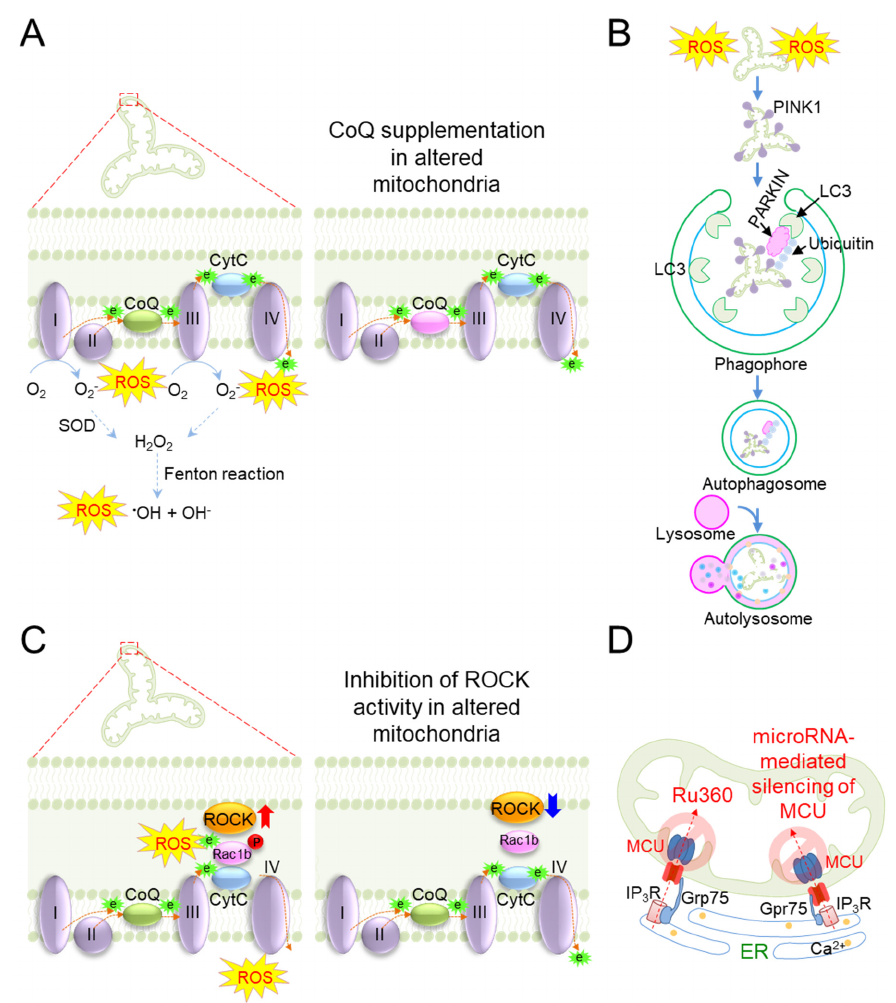
Figure 5. Targeting mitochondrial oxidative stress as a therapeutic strategy for aging and age-related diseases: ( A ) Senescent cells show a lack of coenzyme Q (CoQ), which transports electrons from complex II to III (green CoQ indicates CoQ deficiency). Senescent cells deficient in CoQ exhibit electron leakage as electron transport in ETC is hindered. Premature electron leakage from ETC combines with oxygen to generate mitochondrial ROS. By contrast, mitochondria-targeted CoQ (MitoQ) treatment lowers mitochondrial ROS production, consequently resulting in a significant reduction in senescence-associated symptoms (pink CoQ indicates high levels of CoQ); e: electron. ( B ) Mitochondria damaged by high levels of mitochondrial ROS recruit PTEN-induced putative kinase protein 1 (PINK1) and ubiquitin ligase PARKIN. PINK1 activates PARKIN recruitment to the OMM for ubiquitylation of OMM proteins in damaged mitochondria. The creation of polyubiquitin chains in OMM proteins recruits autophagy receptor proteins that interact with LC3 (microtubule-associated protein 1A/1B light chain 3) in the phagophore. Then, damaged mitochondria are eliminated by the subsequent formation of the phagophores, autophagosomes, and autolysosomes. ( C ) Reduction in mitochondrial oxidative damage by directly targeting genes that regulate the activity of ETC components. ROCK activation phosphorylates Rac1b, making it easier for Rac1b to interact with cytochrome c. This interaction steals electrons from cytochrome c and causes a partial reduction in oxygen, triggering mitochondrial ROS production. Inhibition of ROCK activity prevents Rac1b from intercepting electrons from cytochrome c, enabling electron transport from complex III to IV. Then, efficient electron transport facilitates complex IV activity, thereby reducing mitochondrial ROS production; e: electron. ( D ) Inhibition of MCU by ruthenium 360 (Ru360) reduces the percentage of mitochondria exhibiting Ca 2+ overload and subsequently reduces the production of mitochondrial ROS. MicroRNA-mediated silencing of MCU shields cardiomyocytes from mitochondrial oxidative